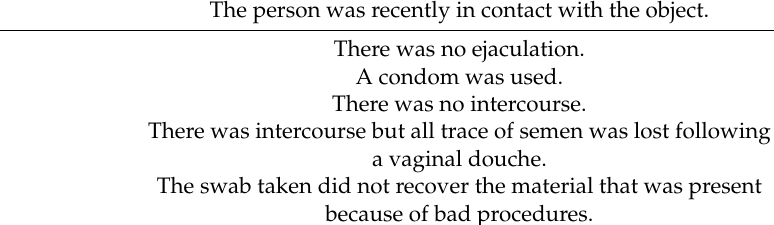
DNA profile of Mr Smith is compatible with the DNA profile